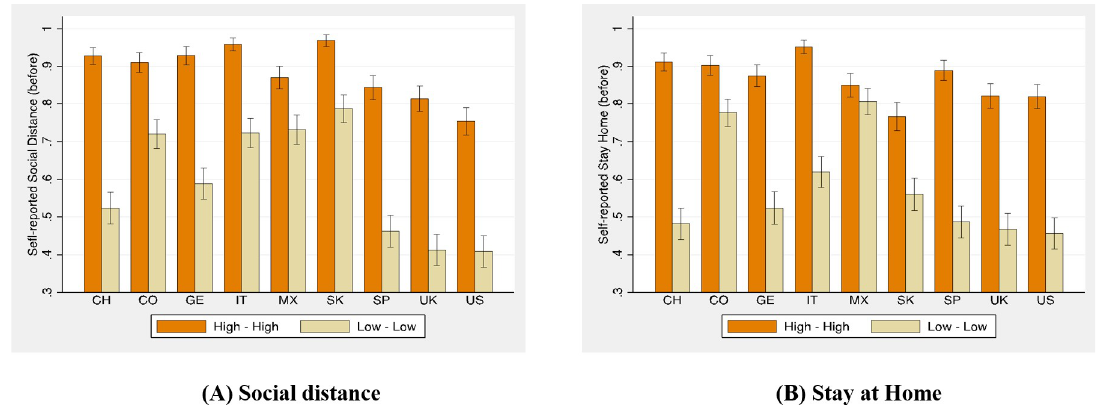
Fig 2. Self-reported compliance and